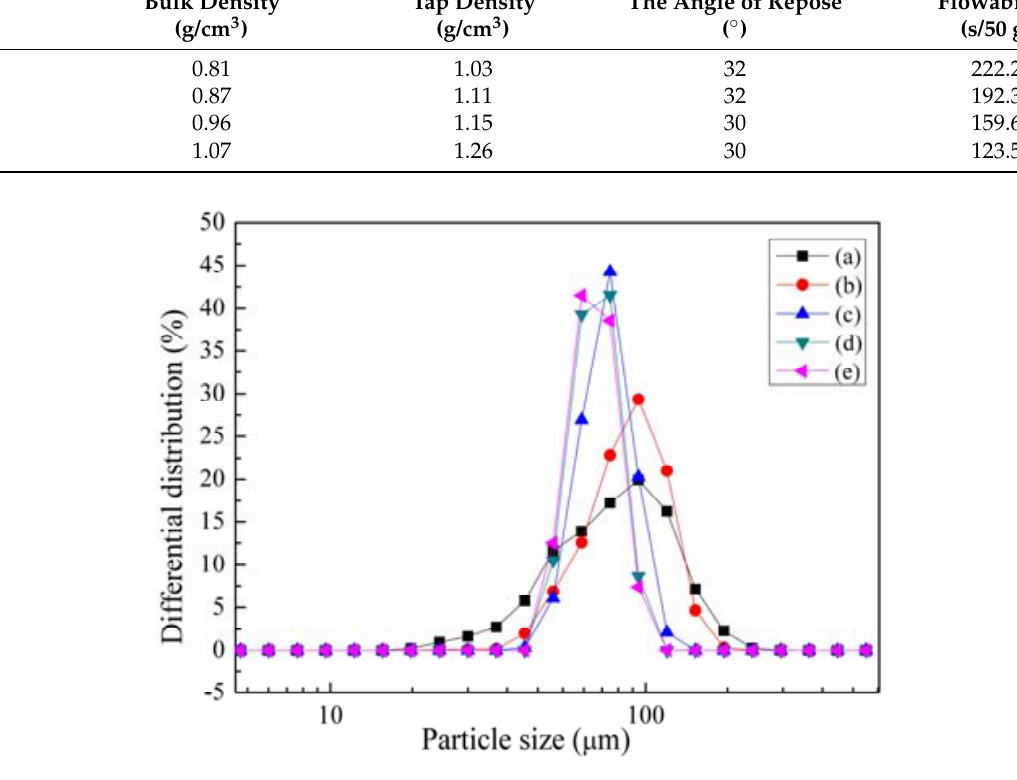
Figure 4. Particle size distribution of granulation powders at different sintering temperatures: ( a ) as - synthesized, ( b ) 1200 °C for 2 h, ( c ) 1300 °C for 2 h, ( d ) 1400 °C for 2 h, and ( e ) 1500 °C for 2 h.